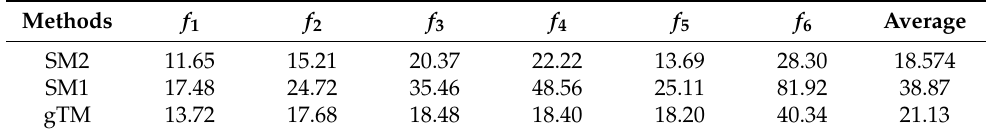
Table 2. Average number of function-evaluations per point (AFPP) for each method on the test functions.